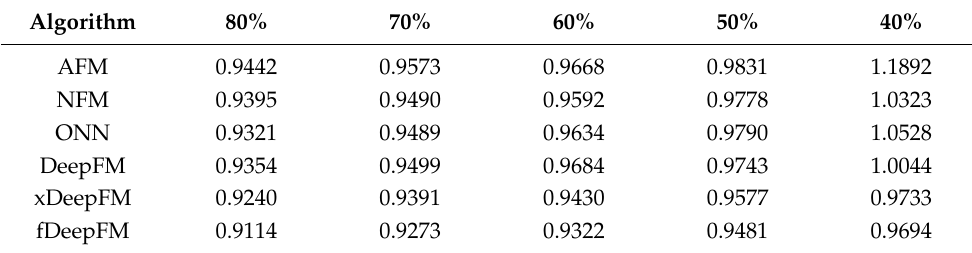
Table 3. Comparison experiments of algorithm effects under a different scale of sparsity.